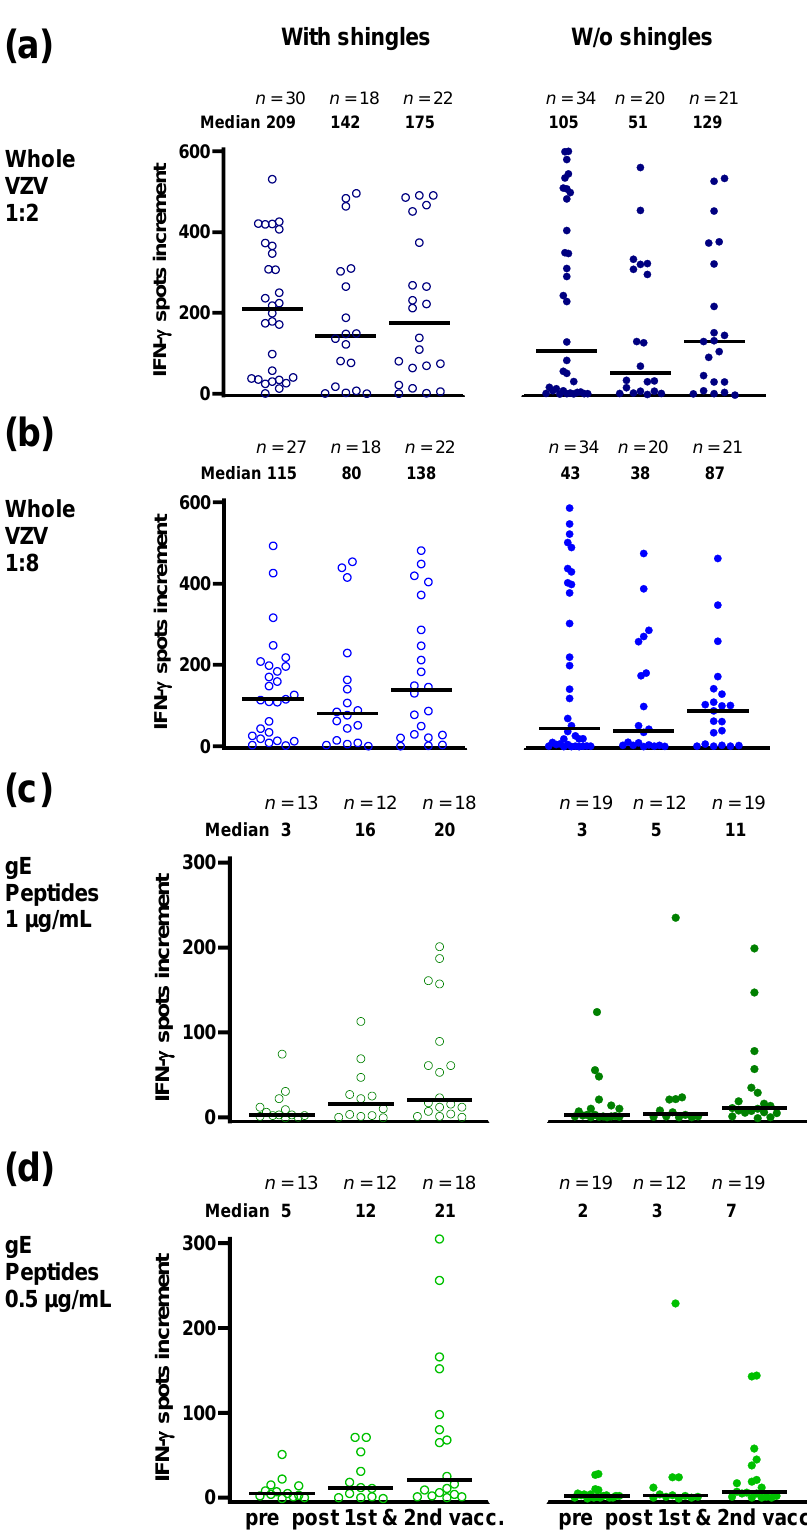
Figure 5. Varicella-zoster virus-specific ELISpot responses in hematopoietic stem cell transplant (HSCT) recipients prior to and after the first and second vaccination with Shingrix™. Panel ( a ) displays responses to a whole VZV antigen (Behring), at a dilution of 1:2, and panel ( b ) at a fourfold higher dilution of 1:8. Panel ( c ) displays responses to a peptide pool of glycoprotein E (gE) from JPT, used at concentration of 1 µg/mL per peptide, in panel ( d ) at 0.5 µg/mL. Open circles (left panel) indicate recipients with shingles and filled circles (right panel) without (w/o) shingles. In patients with and without shingles blood sampling was performed at a median of 35 and 37 months after transplantation, respectively. In patients with and without shingles the median interval between first vaccination and blood sampling was 80 and 61 days and between second vaccination and blood sampling 79 and 78 days, respectively. VZV-specific spots were determined as stimulated minus non-stimulated (background) values (spots increment). Horizontal lines represent median values.